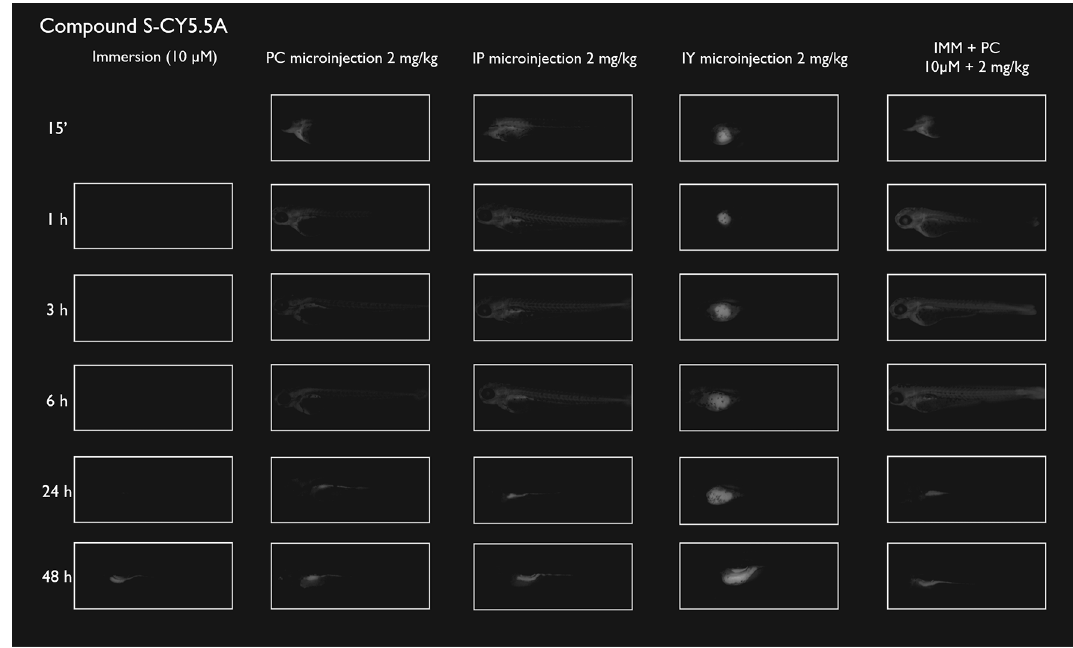
Figure 2. Representative pictures of the spatiotemporal distribution of the fluorescent compound S-CY5.5A. The eleuthero-embryos were exposed to the dye by immersion (10 µM) or microinjection (2 mg/kg) in the pericardial cavity (PC), intraperitoneally (IP) and in the yolk sac (IY), or by a combination of immersion and PC microinjection, for 48 h starting from 3 dpf. Selected images arranged in MS PowerPoint and GIMP (version 2.10.24 https:// www. gimp. org/ 2021) Software.